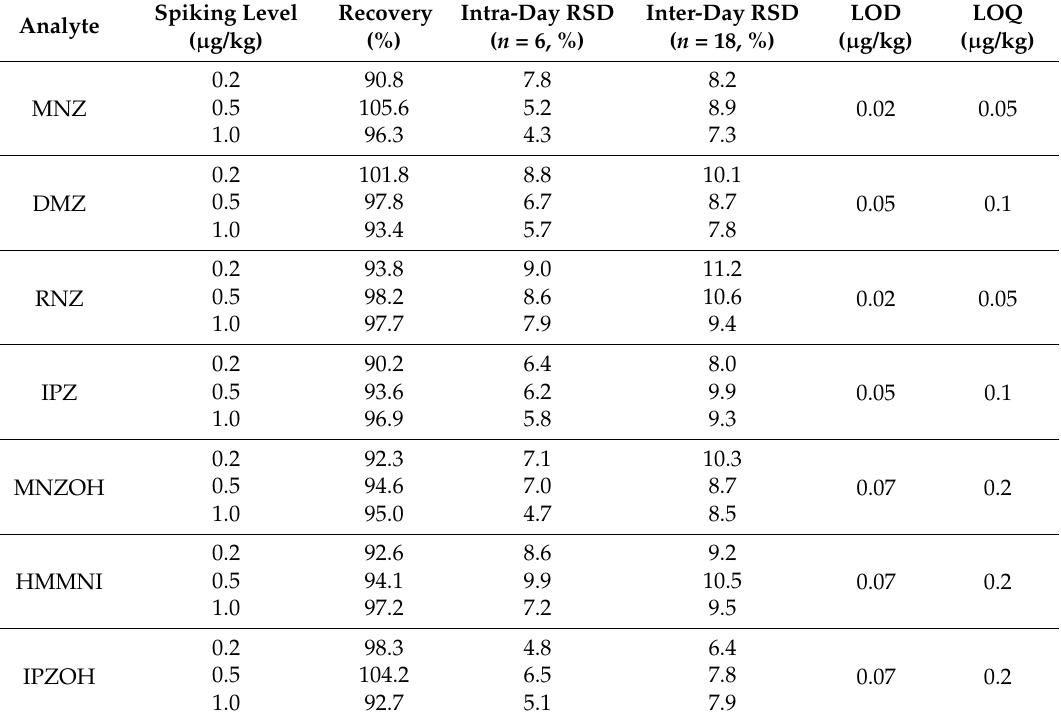
Table 2. Recovery, precision, and sensitivity of the method.